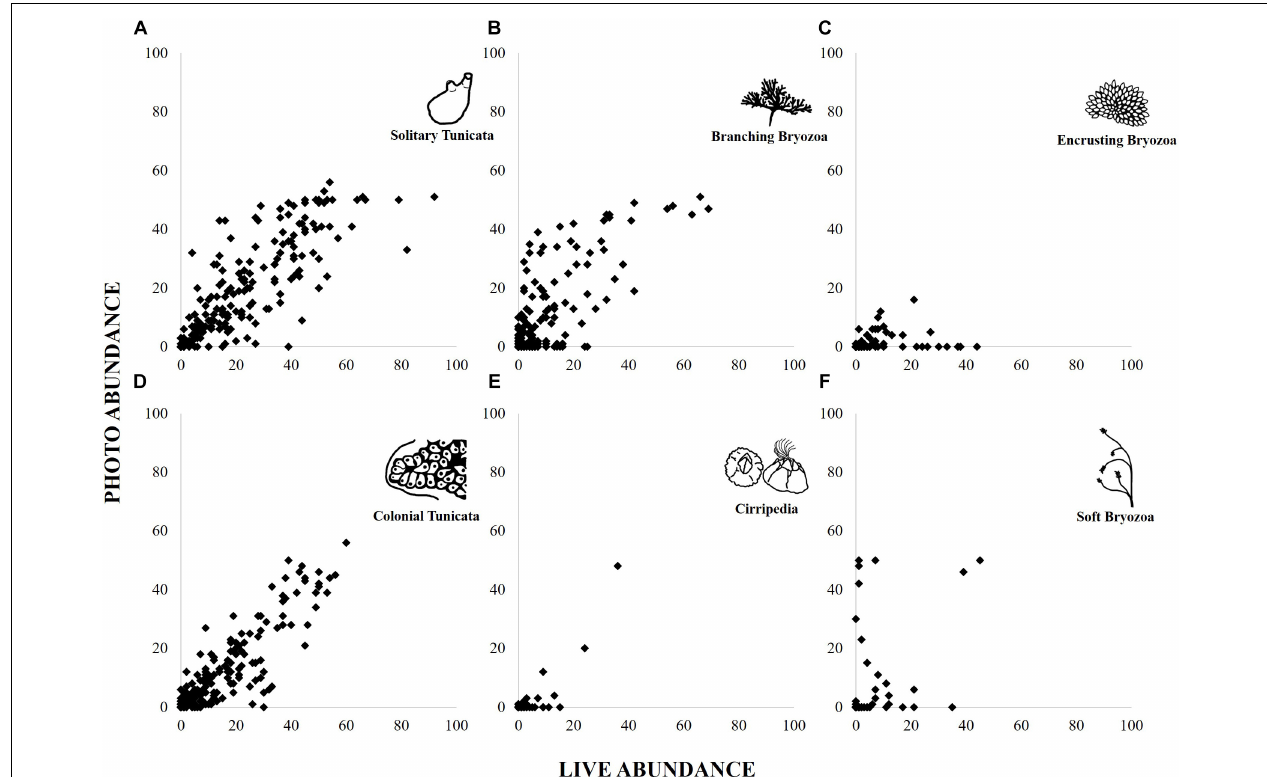
FIGURE 4 | Abundance scores per panel found from live and photographed point counts for six functional groups: Solitary Tunicate (A) , Branching Bryozoa (B) , Encrusting Bryozoa (C) , Colonial Tunicata (D) , Cirripedia (E) , and Soft Bryozoa (F)